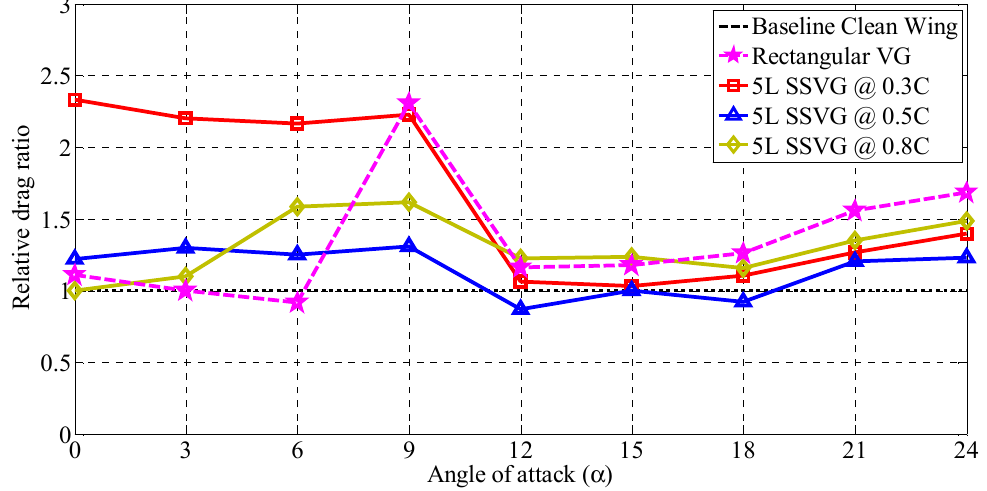
Figure 17. Relative drag ratio vs. angle of attack ( α ) for baseline and modified model with large-sized (5L) SSVG.